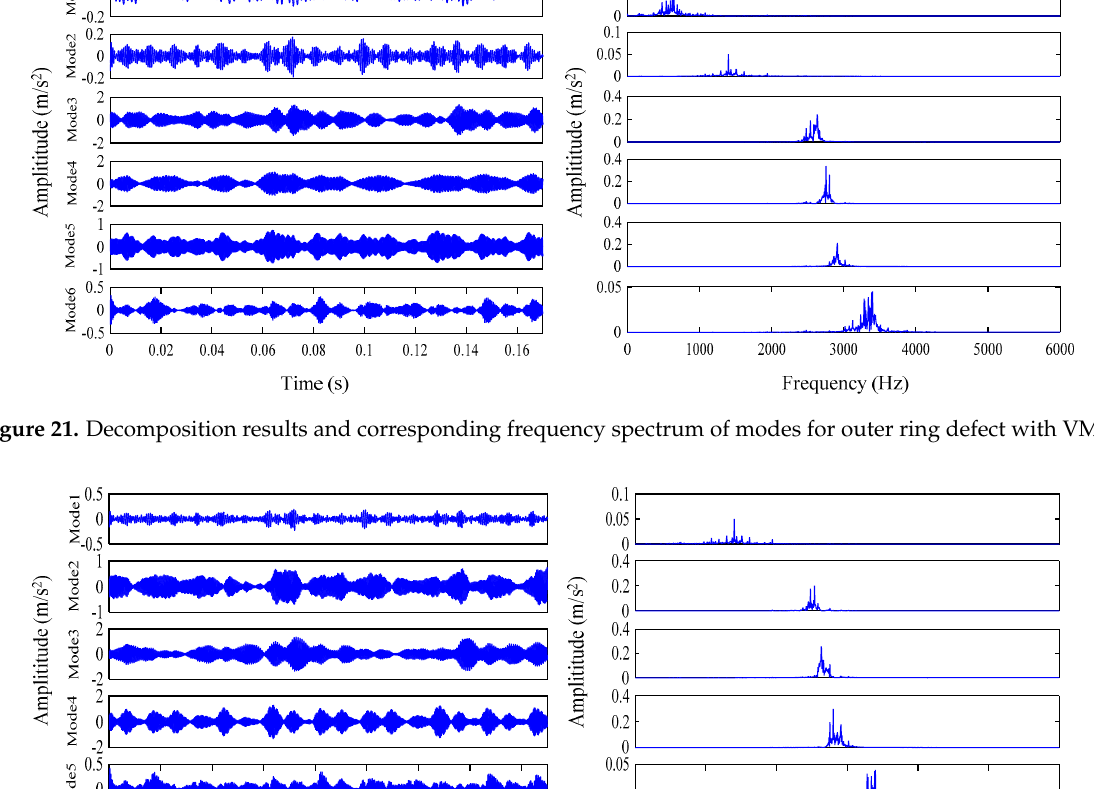
Figure 20. Decomposition results and corresponding frequency spectrum of IMFs for outer ring defect with CEEMD.